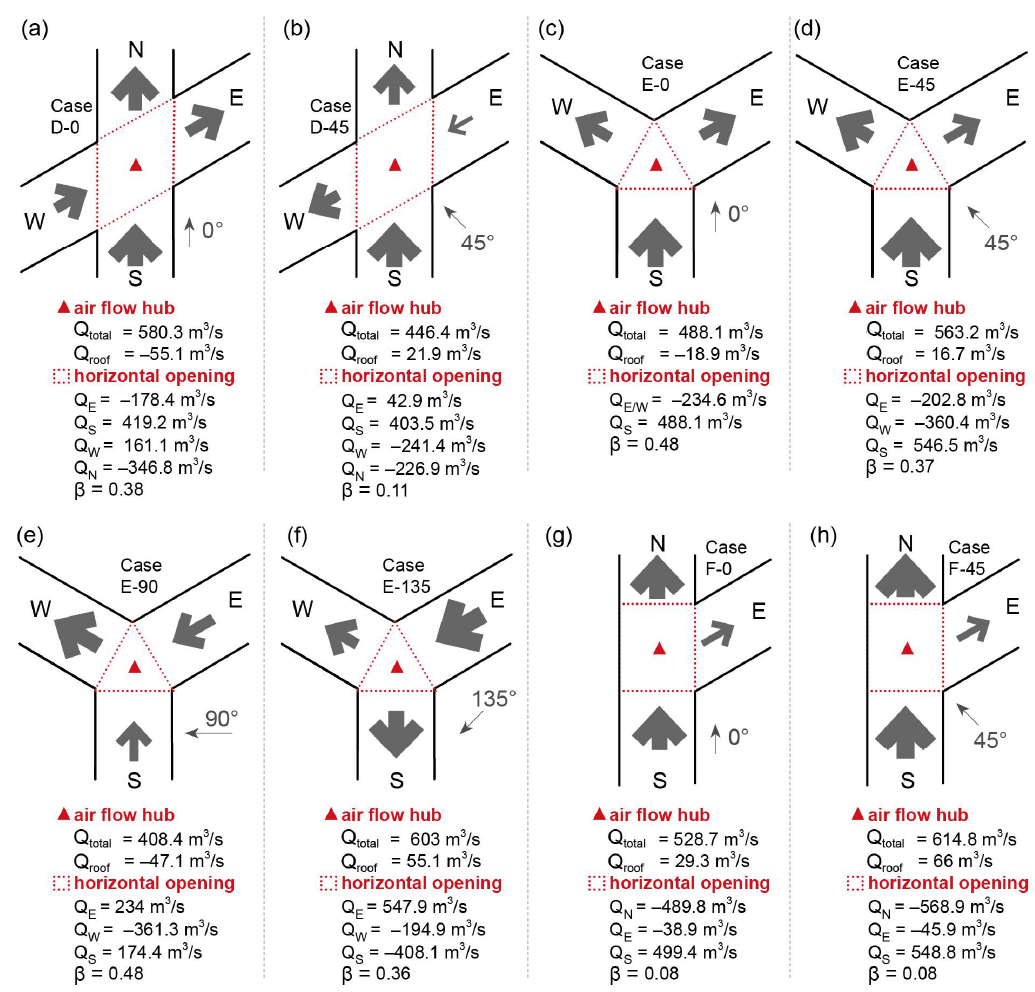
Figure 12. Volumetric flow rate for the intersection and its interfaces in Cases ( a , b ) D, ( c – f ) E, and ( g , h ) F.